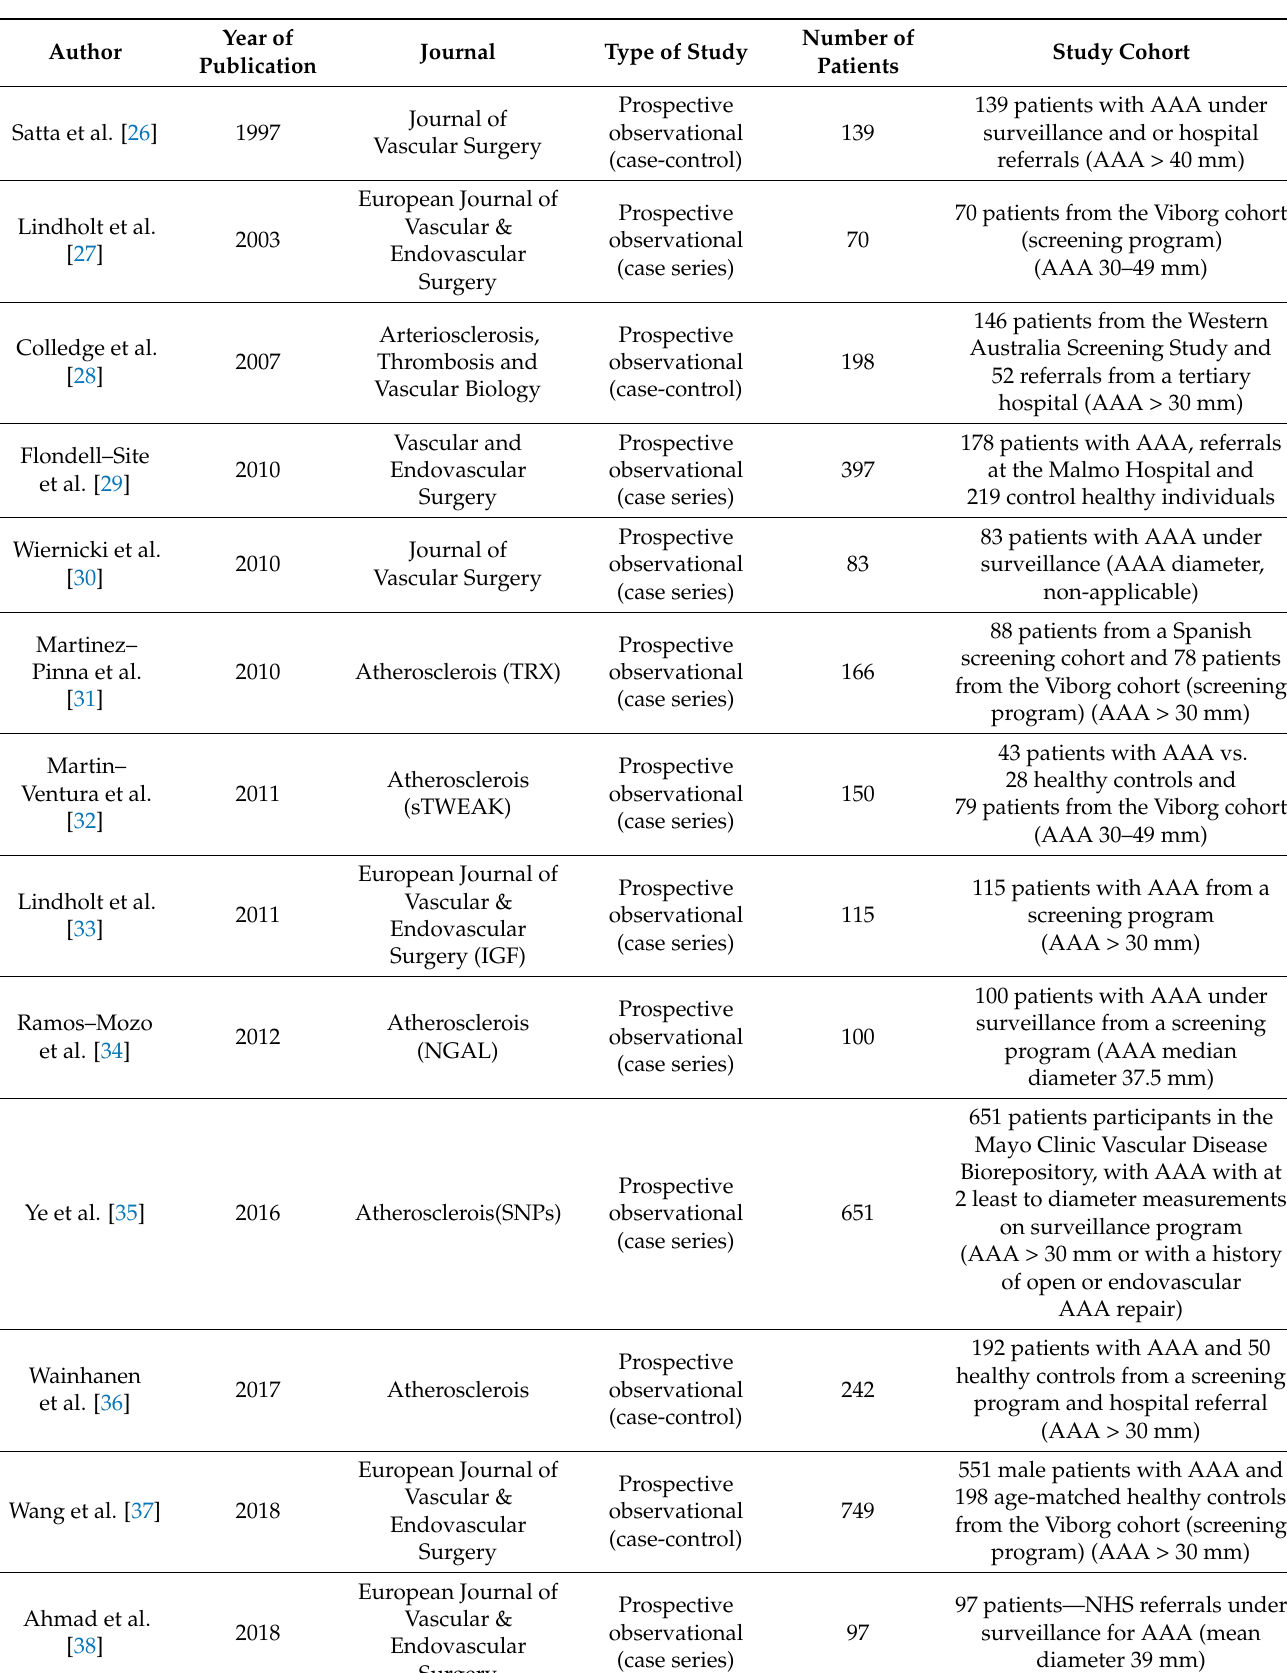
Table 2. General characteristics of studies on circulating experimental